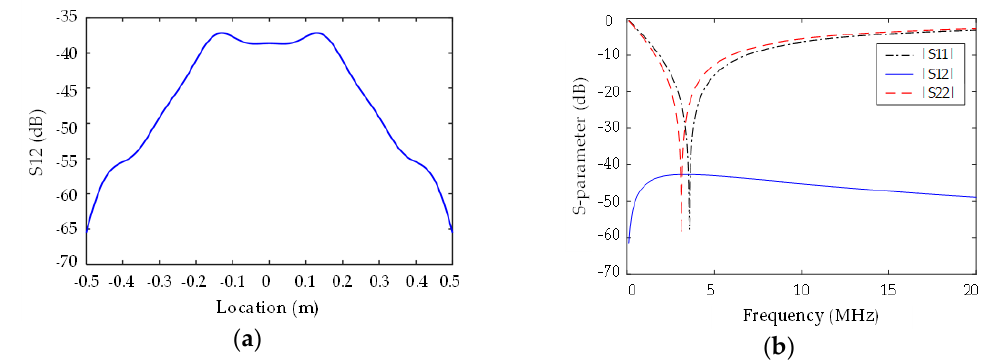
Figure 11. S-parameters of antenna system: ( a ) S12 with the location of on-board antenna. ( b ) S-parameters of antenna system when on-board antenna located right above the EMI radiation antenna.